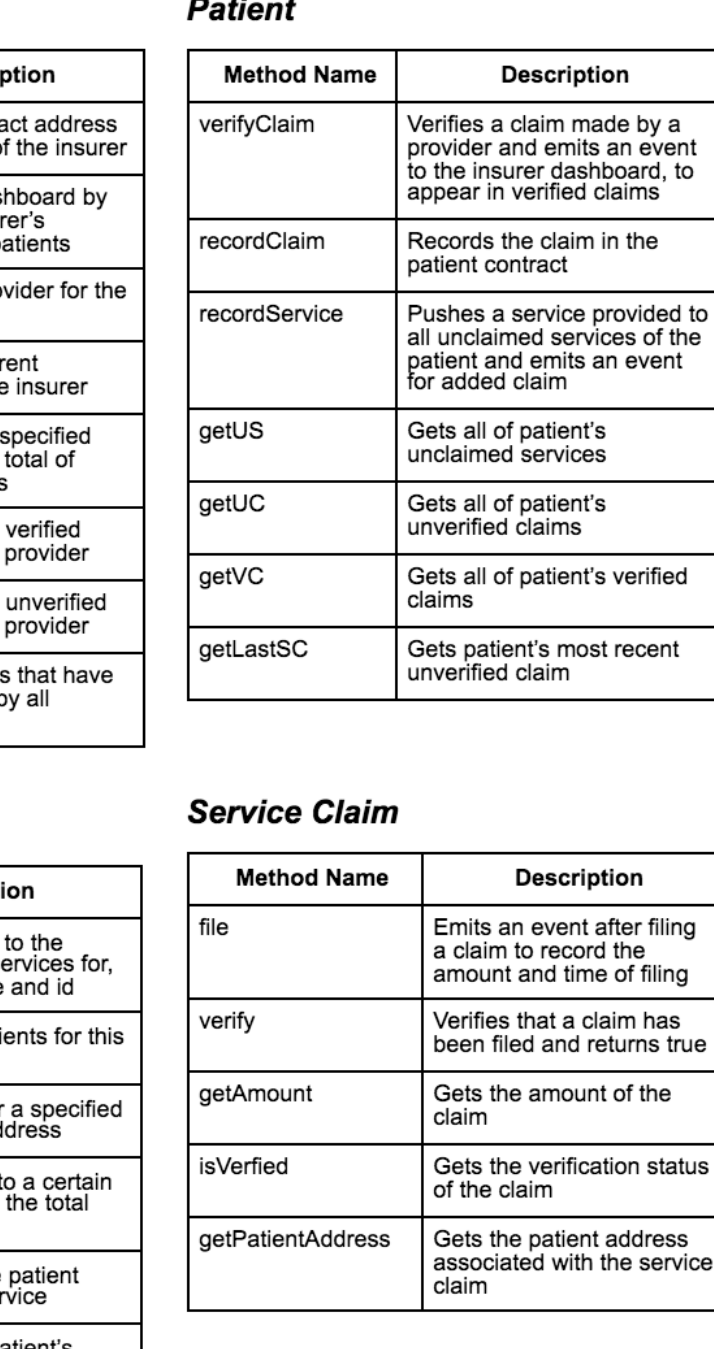
Figure 5. Description of the framework’s smart contract function